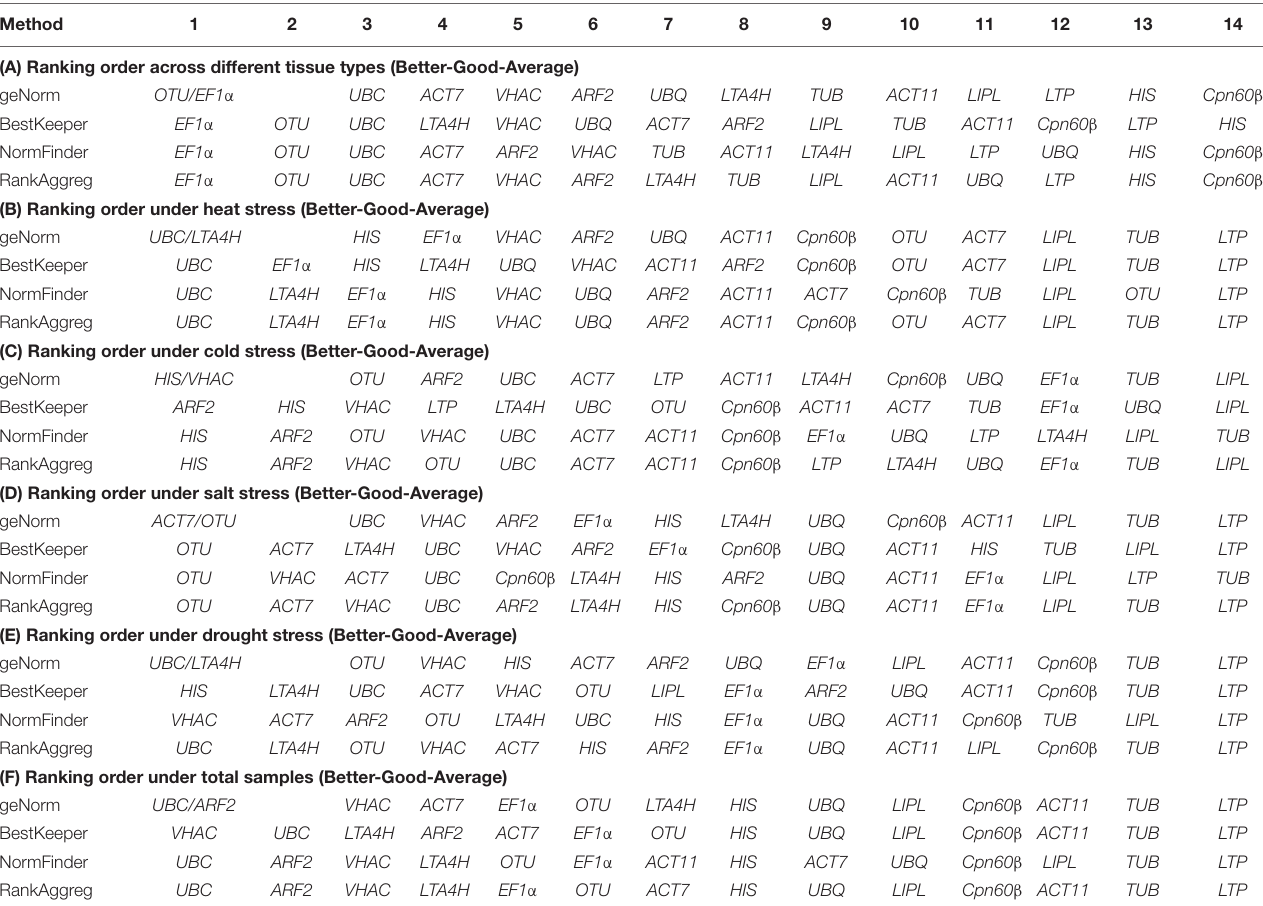
TABLE 5 | Expression stability ranking of the 14 candidate RGs.